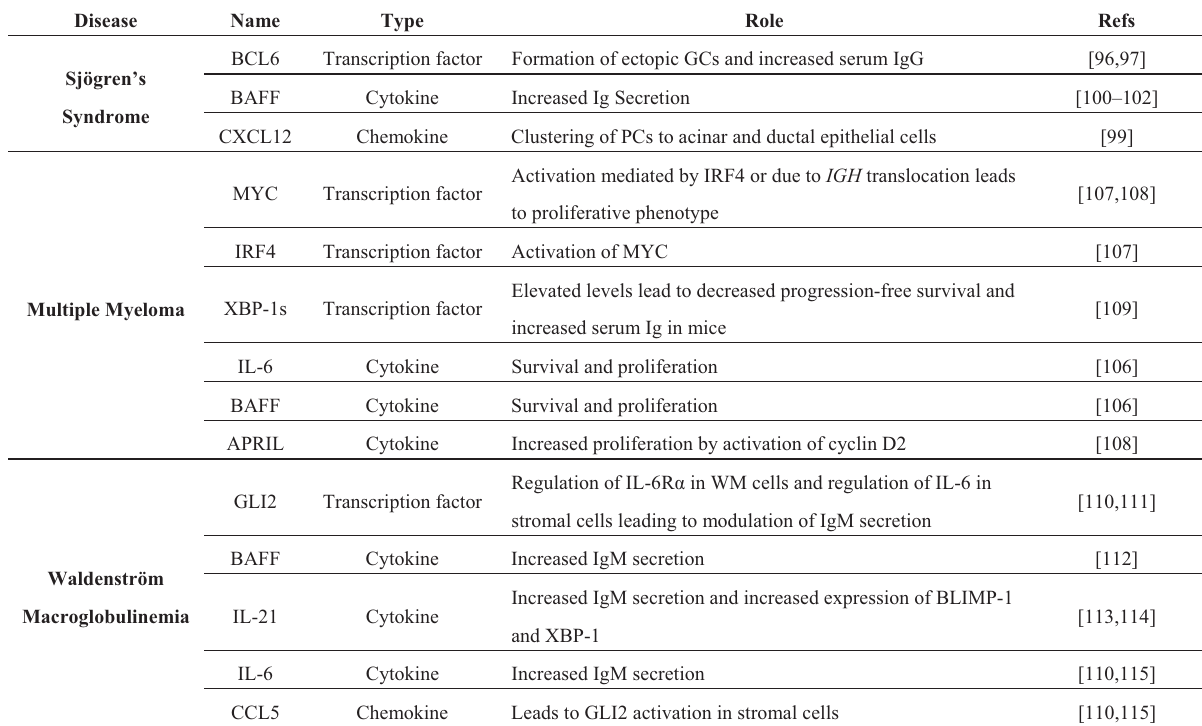
Table 1. Proteins involved in dysregulated Ig production in autoimmune and malignant diseases. Proteins involved in dysregulated Ig production in the autoimmune disease, Sj(cid:4)gren’s syndrome, and the malignant diseases, multiple myeloma and Waldenstr(cid:4)m